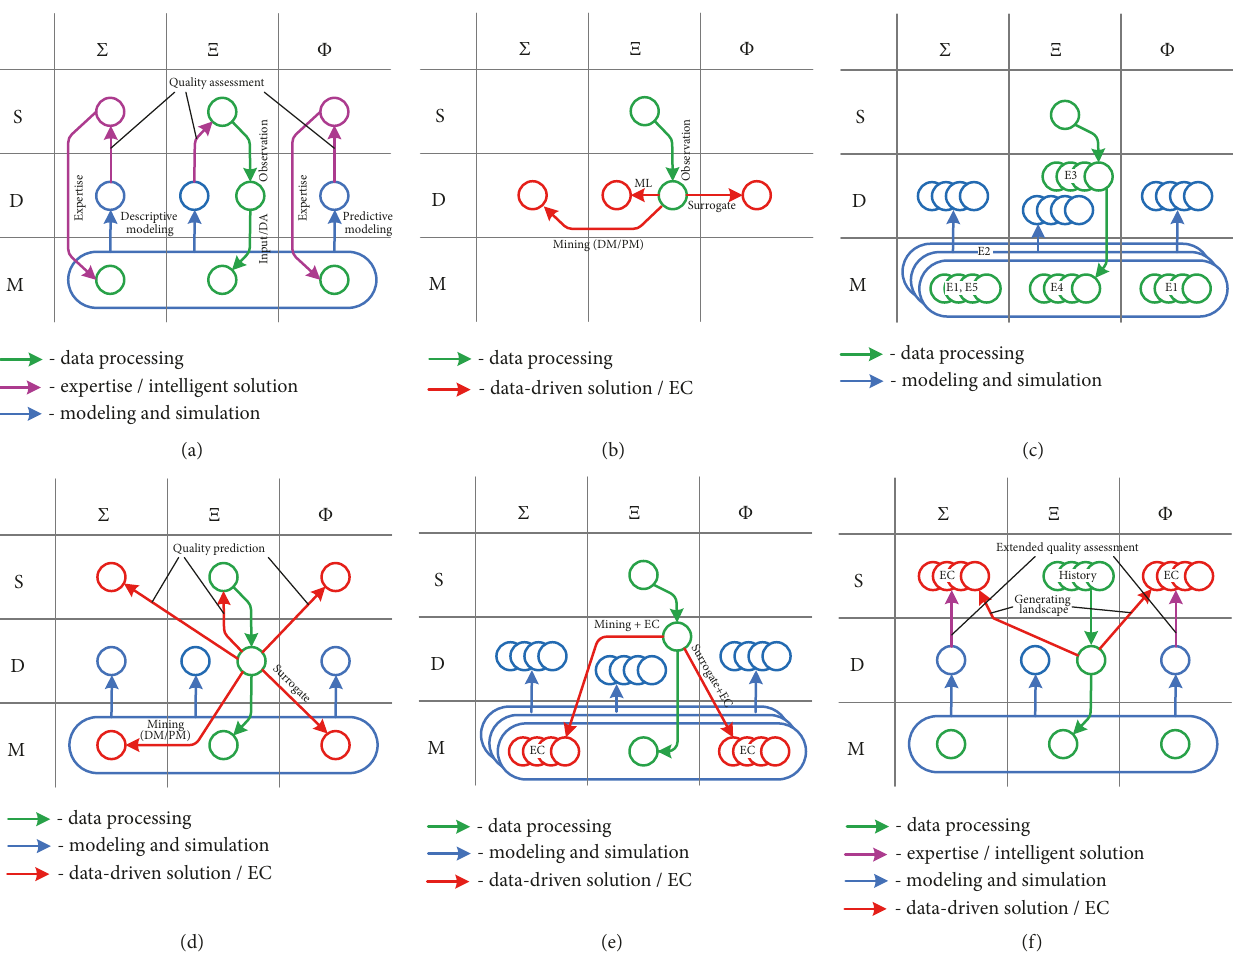
Figure2:Complexmodelingpatterns:(a)regularmodeling;(b)data-drivenmodeling;(c)ensemble-basedmodeling;(d)data-drivensupport of complex modeling; (e) EC in hybrid complex modeling; (f) evolutionary space discovery in hybrid complex modeling.